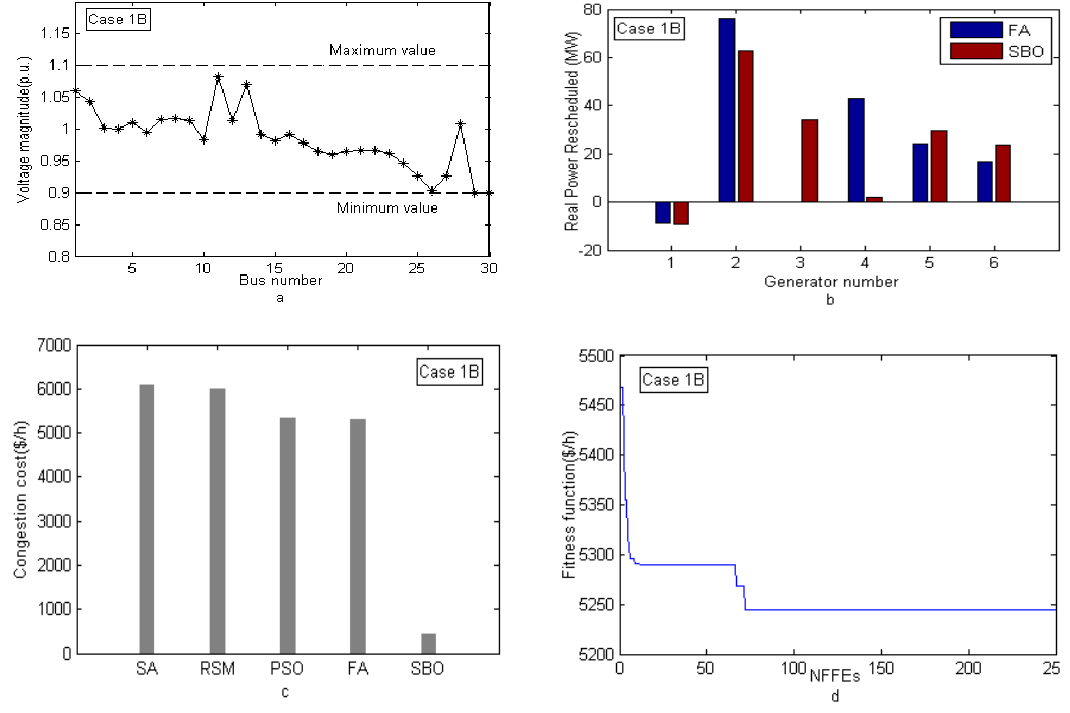
Figure 2. Simulation results for Case 1B. ( a ) voltage magnitude in p.u.; ( b ) change in real-power in MW; ( c ) congestion cost in $/h; ( d ) convergence profile.